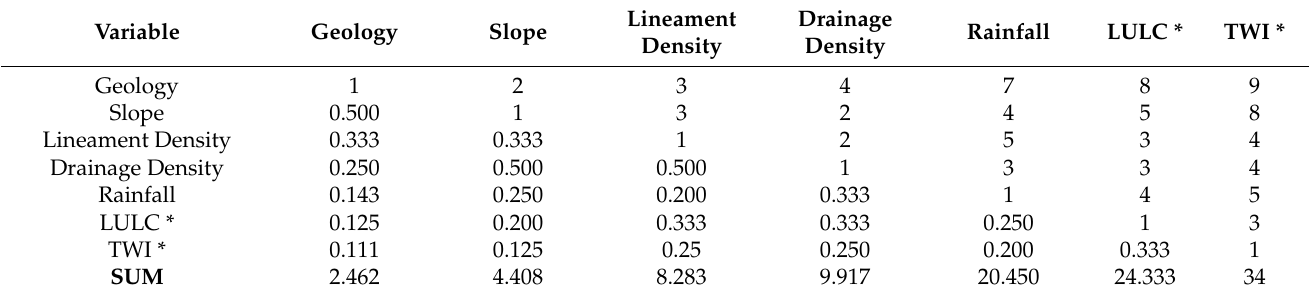
Table 2. Pairwise Comparison Matrix of seven variables for AHP method.